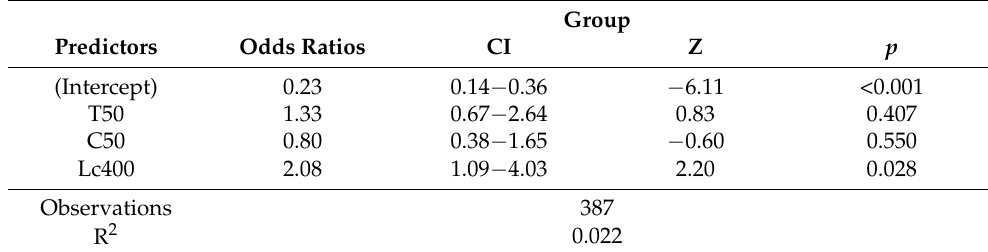
Table A2. Relation between the place of residence and Group classification before matching